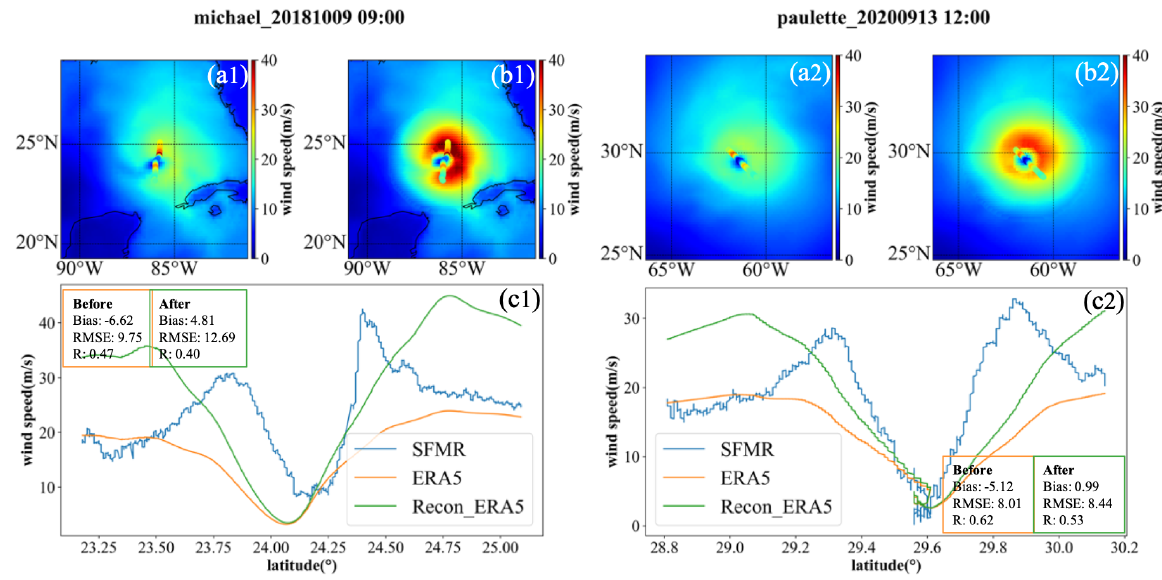
Figure 11. Comparison of field ( a1 – b2 ) and profile ( c1 , c2 ) before and after tropical cyclone recon- struction at Michael in 2018 and Paulette